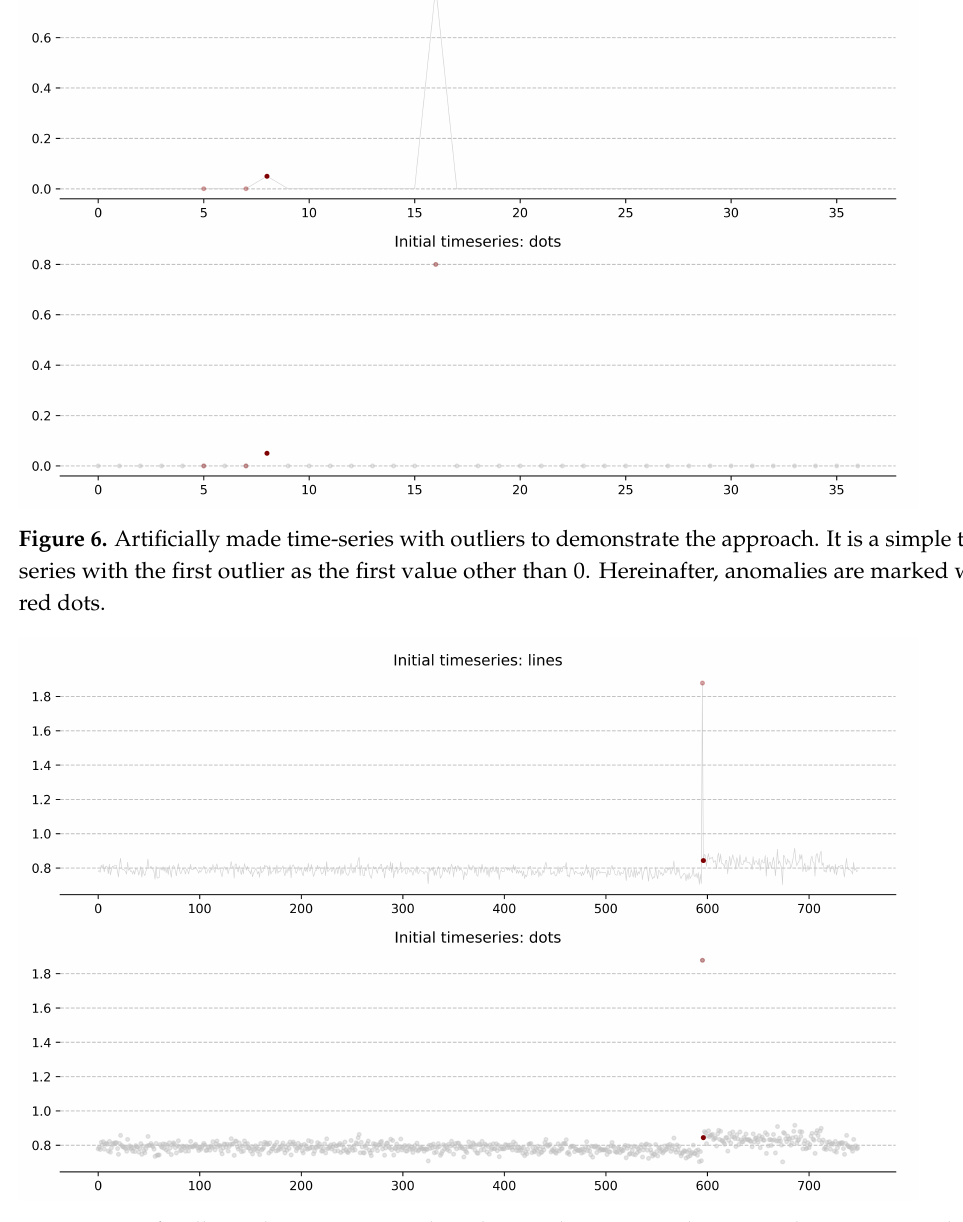
Figure 7. Artificially made time-series with outliers to demonstrate the approach. Non-seasonal time series with